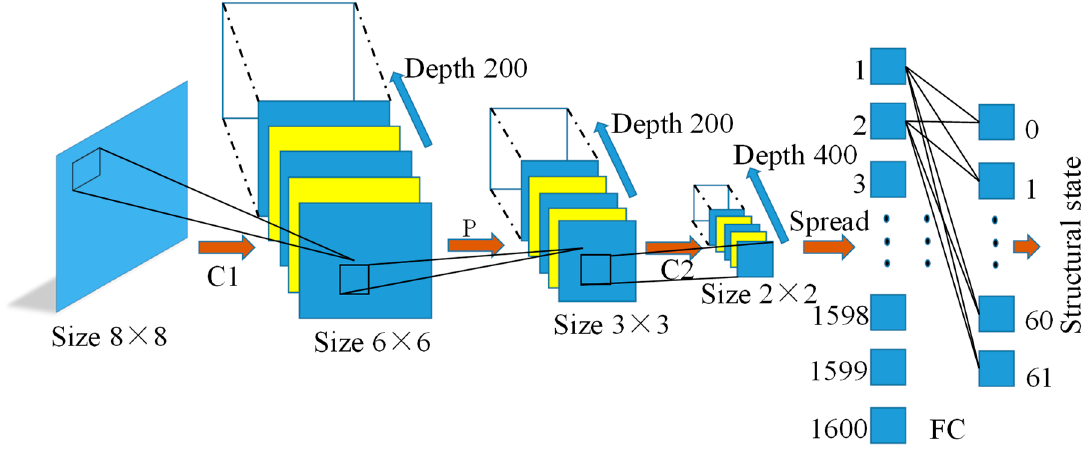
Figure 6. Convolutional neural network (CNN) framework. C1, C2: Convolution layer; P: Pooling layer; FC: Fully connected layer. Table 1. Structural parameters of the CNN.